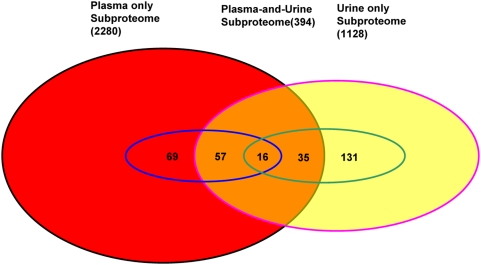
Diagram of proteins found in the three subproteome datasets.There are 2280 proteins in the plasma-only subproteome (red), 394 proteins in the plasma-and-urine subproteome (orange), and 1128 proteins in the urine-only subproteome (yellow). The proteins in blue circles (142 proteins) and green circles (182 proteins) represent effective input-plasma proteins with experimental MWs and effective output-urine proteins with experimental MWs, respectively. Numbers represent the number of shared proteins in the respective overlapping areas.